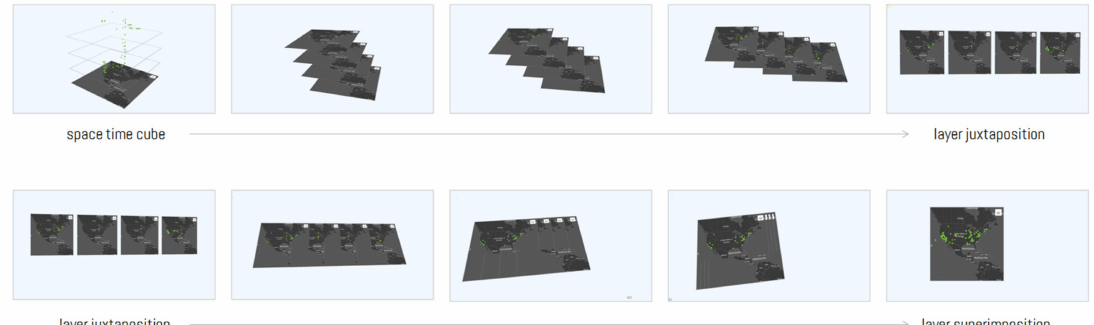
Figure 8. Animated canvas transitions of the PolyCube system, seamlessly translating a space-time cube representation into a juxtaposition perspective ( top row ) and from a juxtaposition into a layer superimposition perspective ( bottom row